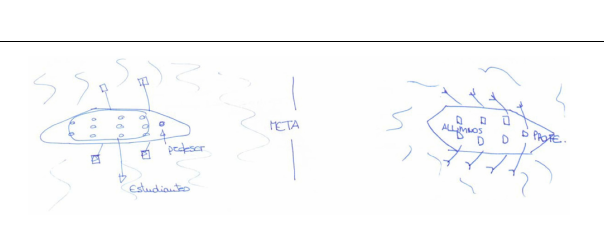
( Figure 4 ): ‘all in the same boat rowing in the same direction’. This is a metaphor identified by Buaraphan (2011) in which will go off-course; however, if the oarsmen stops rowing, then the boat will stop.